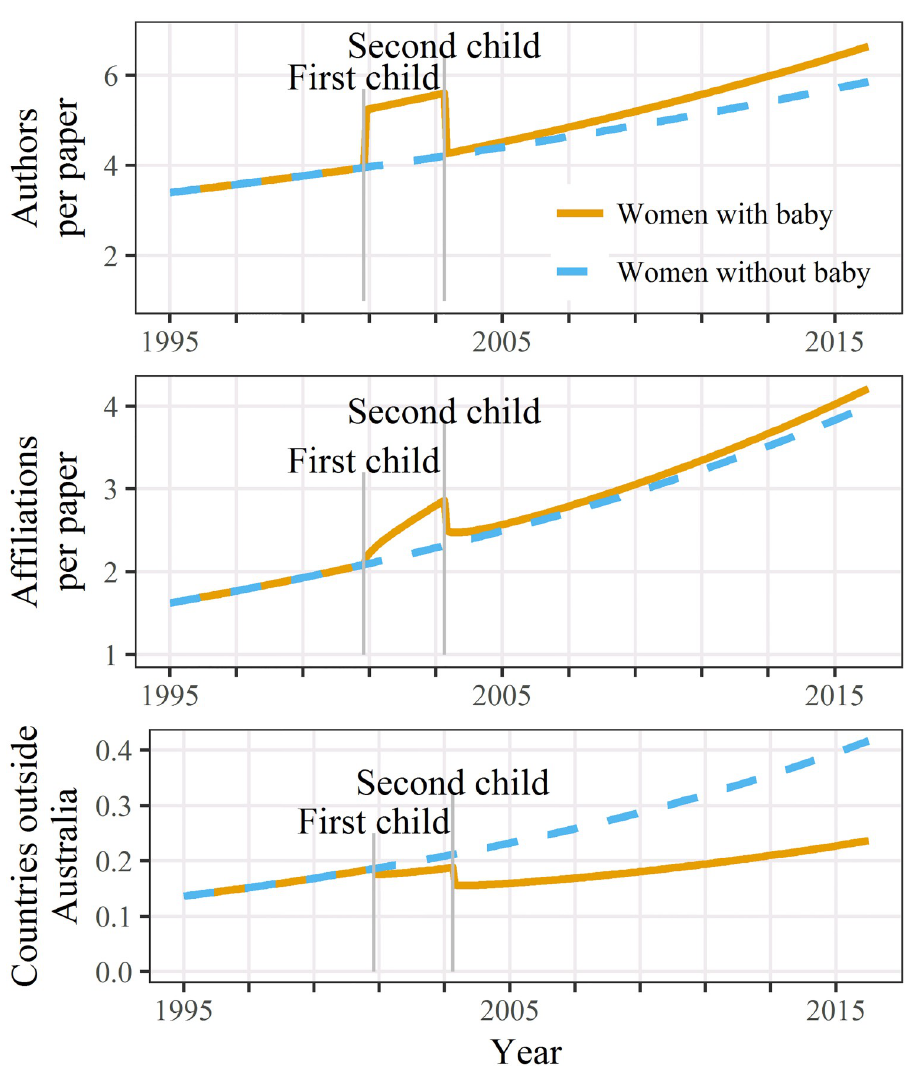
Fig 2. Estimated number of authors, affiliations and co-author countries outside Australia per paper over time for women caring for two children and women caring for none. Estimates shown for a career beginning in